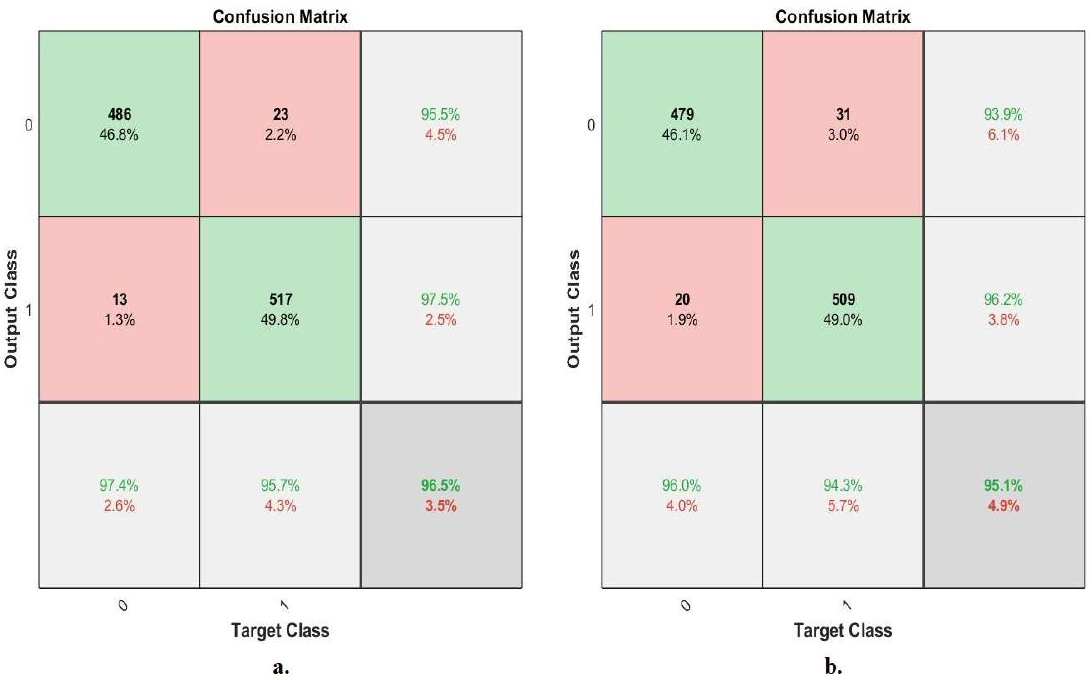
Figure 14. Display of ANN performance based on the features of AlexNet and ResNet-18 models.